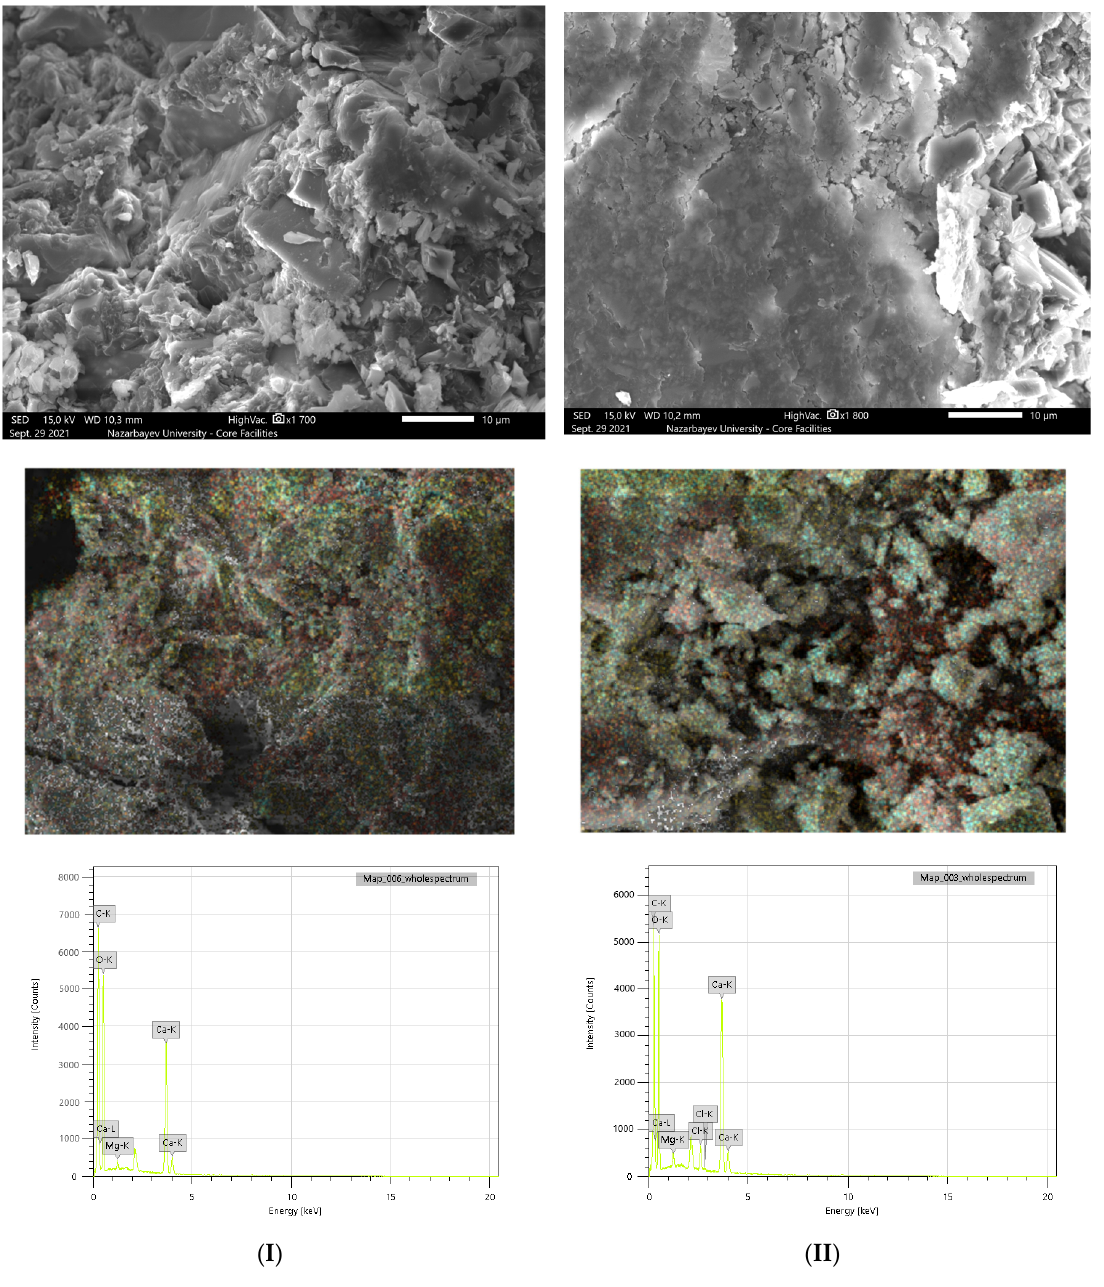
Figure 5. SEM-EDS micrographs of the pristine ( I ) and 5 wt.%-triclosan-loaded ( II ) polymer composites. Table 5. The elemental analysis of the polymeric composites on SEM-EDS (in